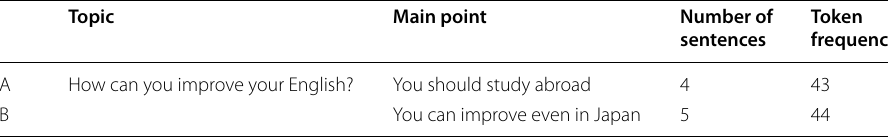
Table 2 Summary of source texts used in this